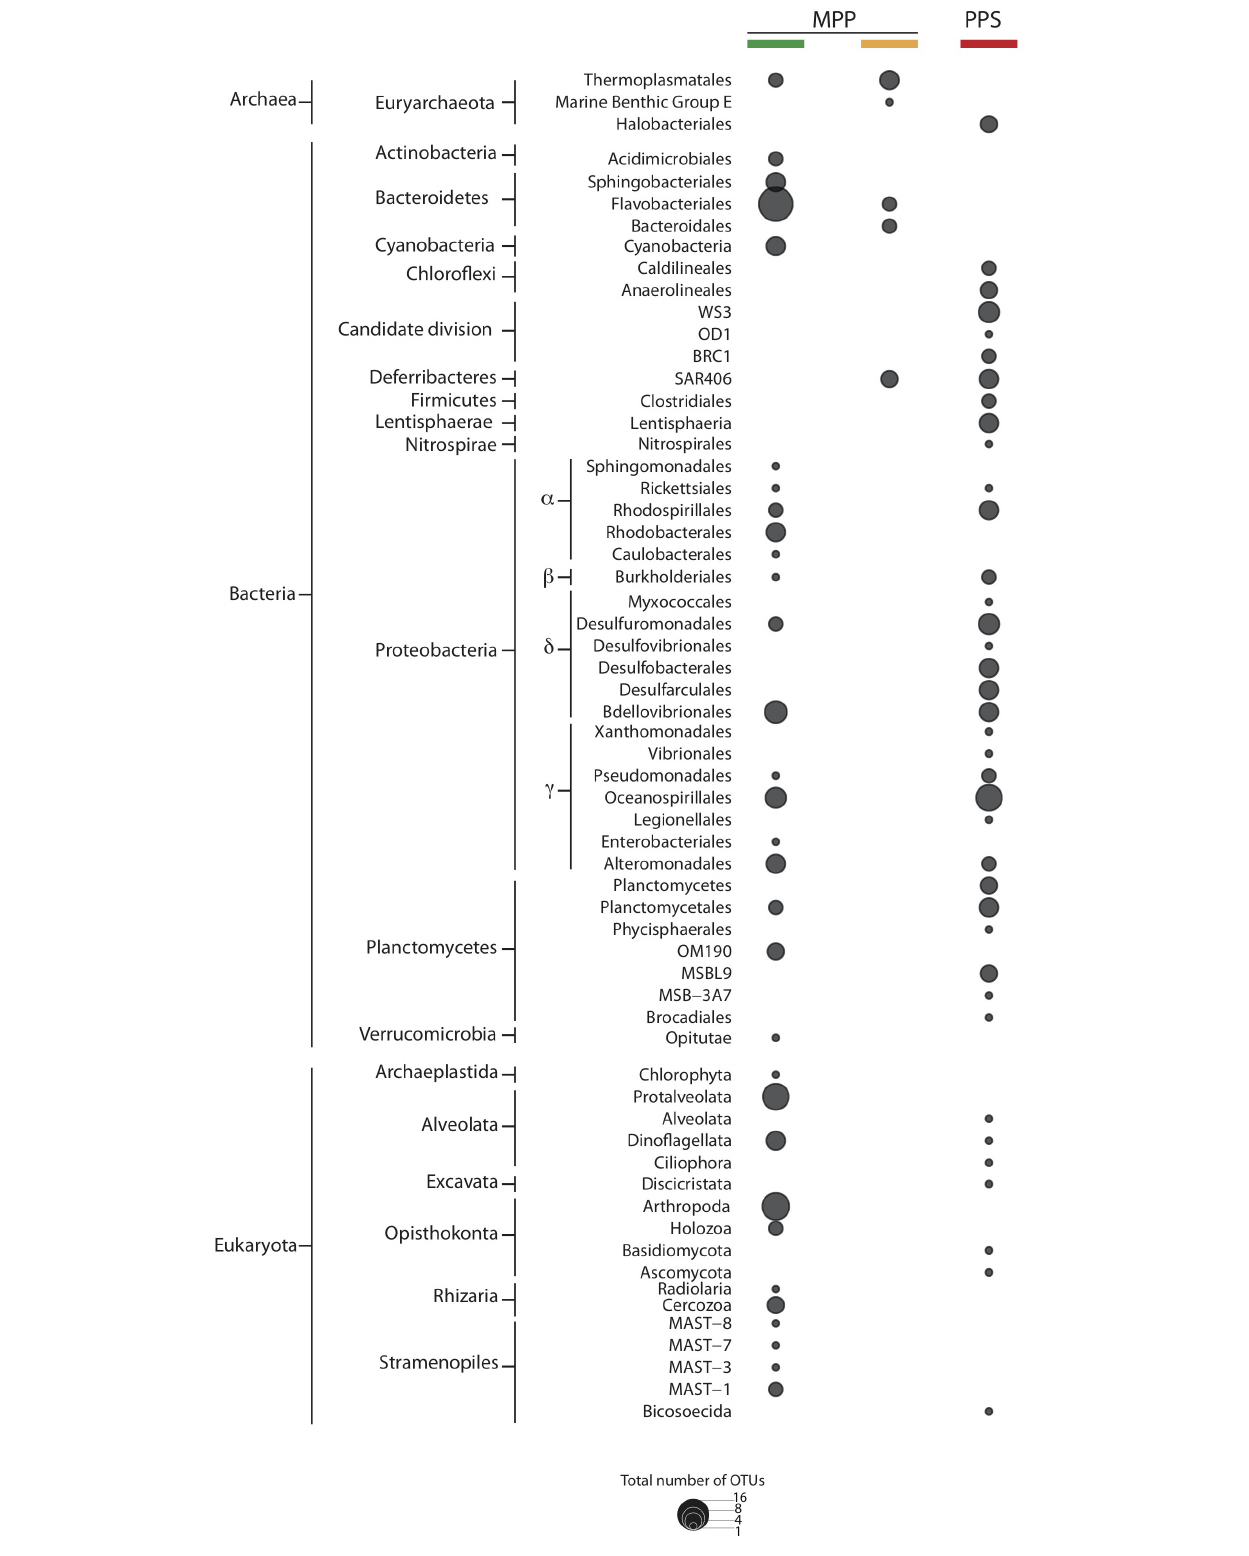
Frontiers in Marine Science |